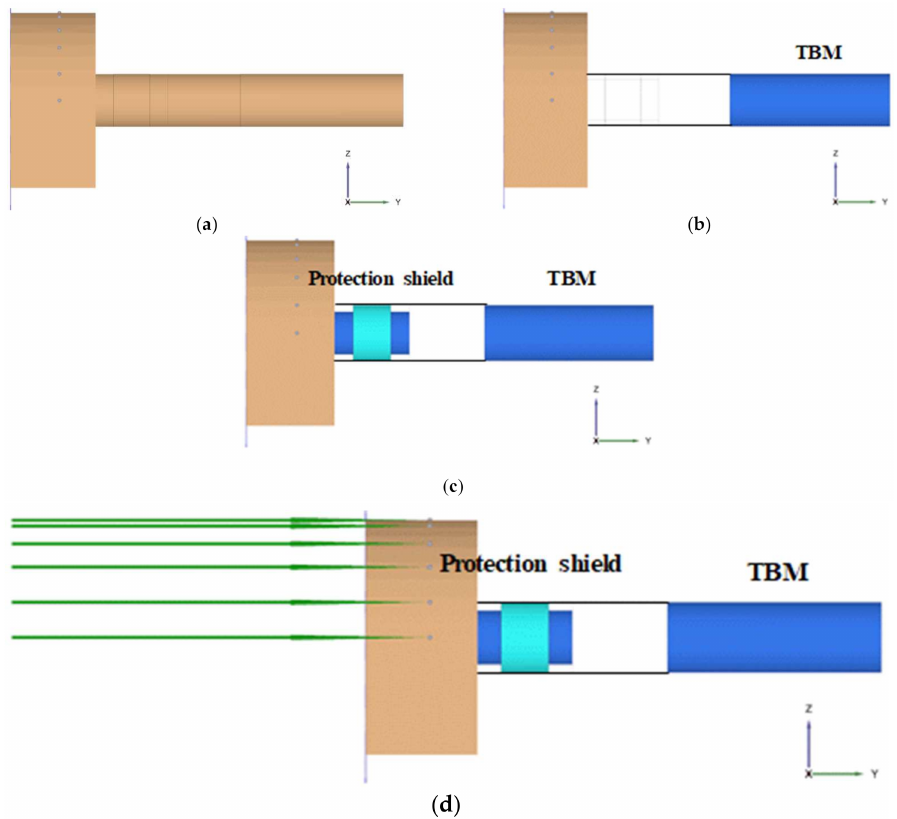
Figure 6. Numerical analysis (construction stage): ( a ) initial stage, ( b ) TBM excavation, ( c ) installation of protection shields, and ( d ) NATM